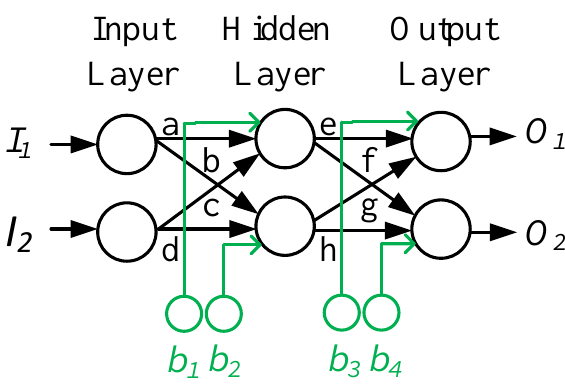
Figure 5. Sample artificial neural network for